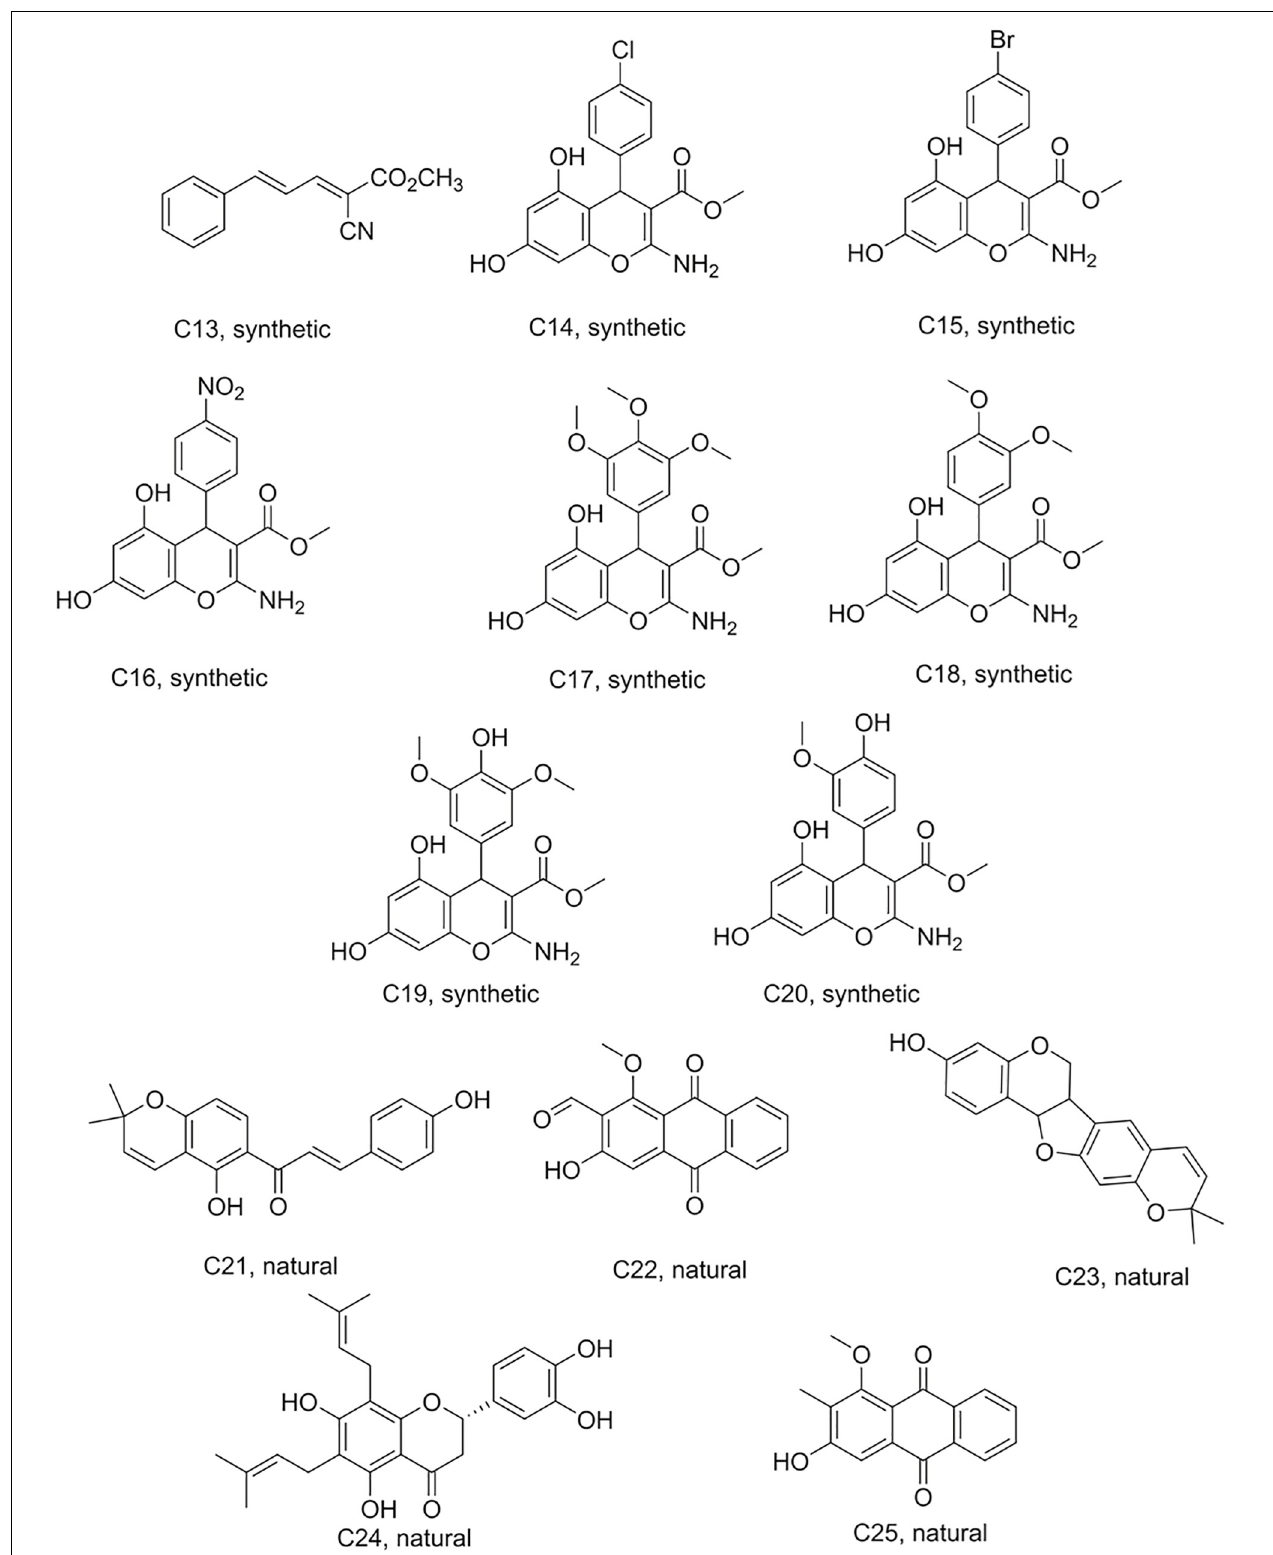
FIGURE 2 | Structures of the compounds tested for anti -M. tuberculosis activity: Ester C13, chromenes C14–C20, and natural products C21–C25 (Ngadjui et al., 1998; Kuete et al., 2014, 2015a; Martin et al., 2018).